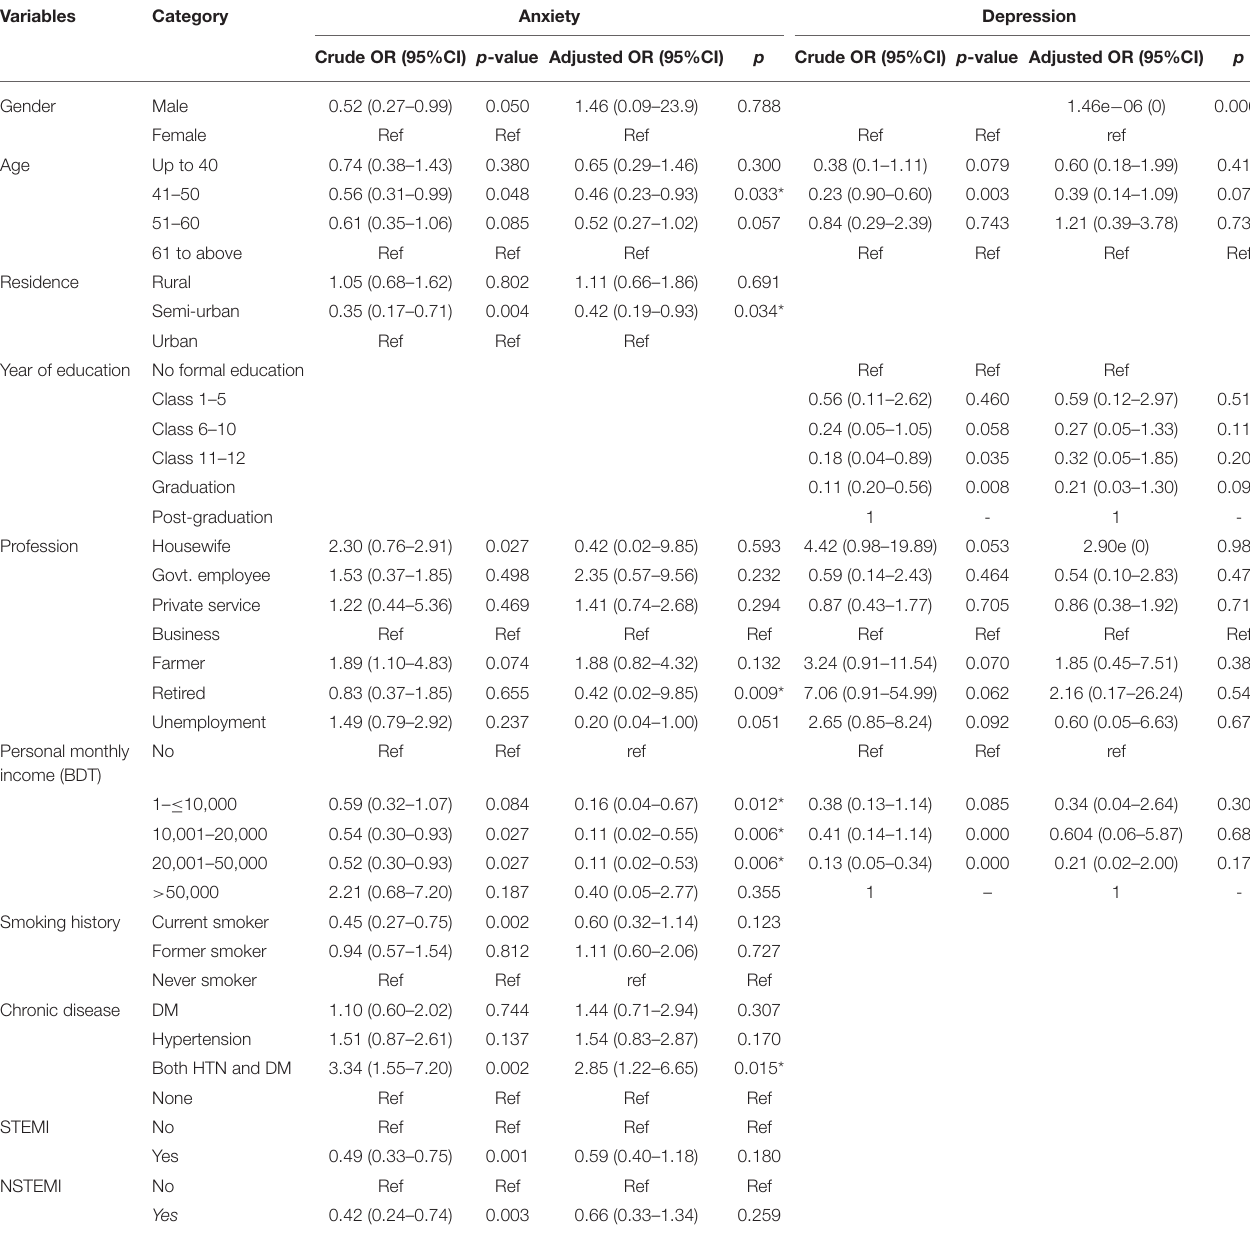
TABLE 5 | Factors associated with anxiety and depression in multivariable logistic regression. Variables Category Anxiety